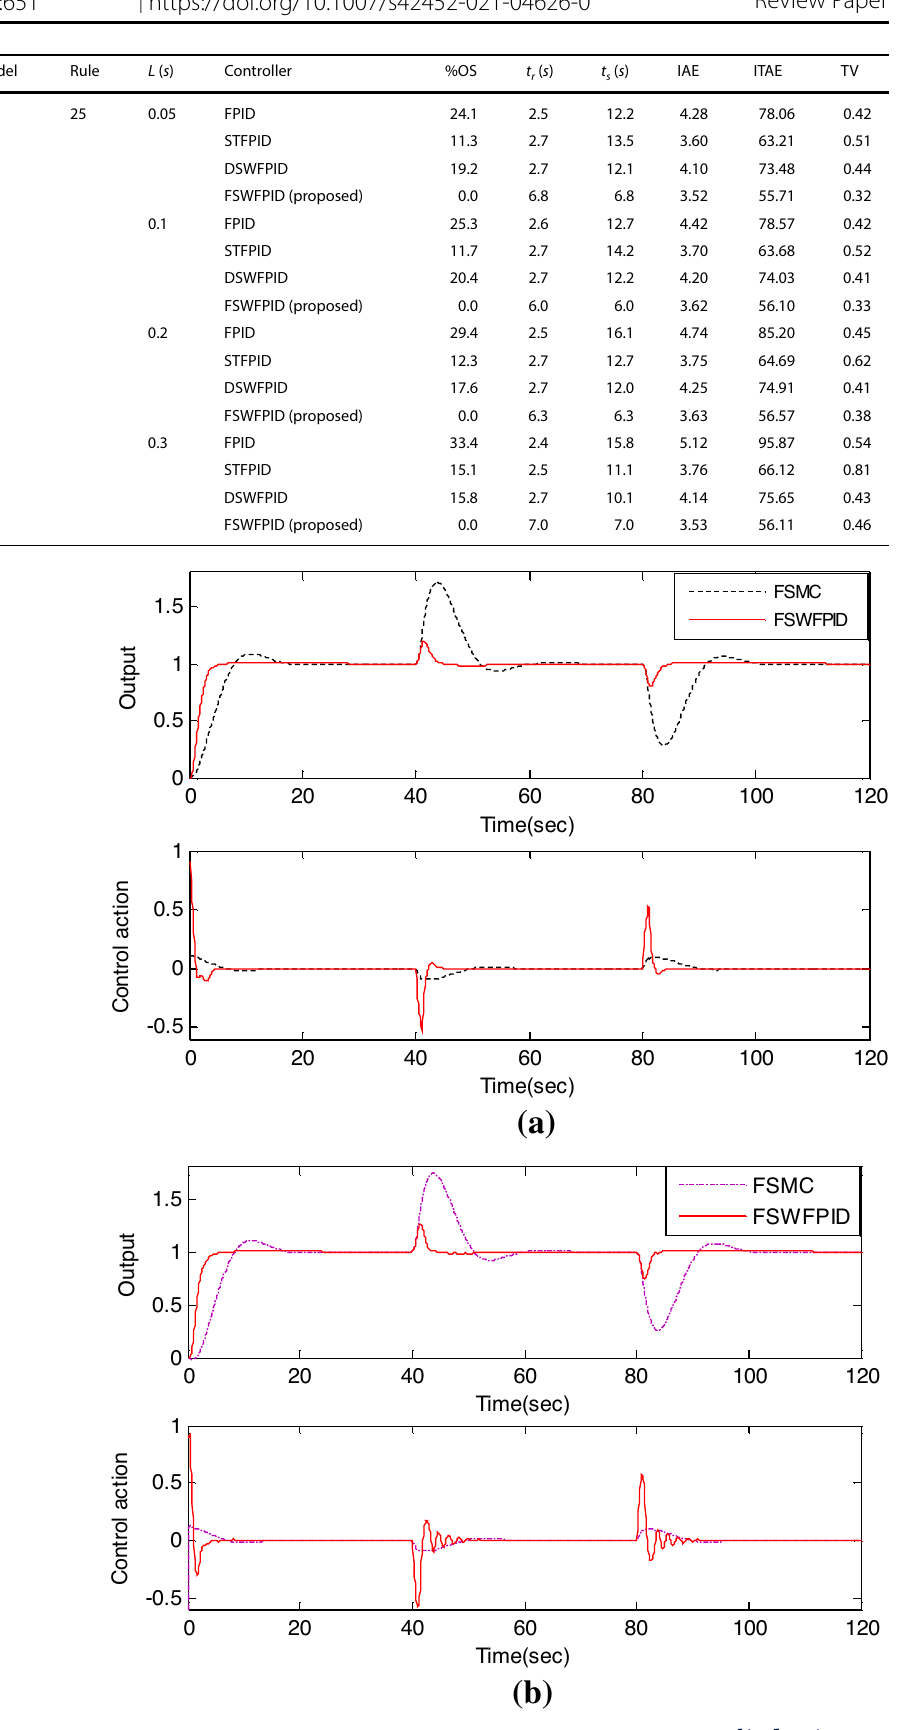
Table 13 Performance analysis for Model IV